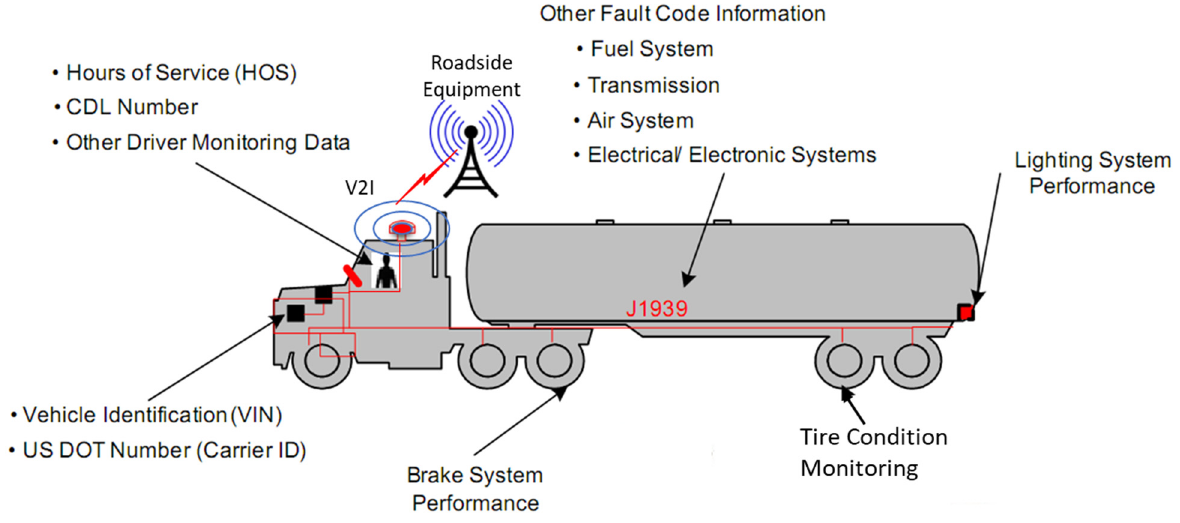
Figure 3. Concept of a Smart Roadside System.